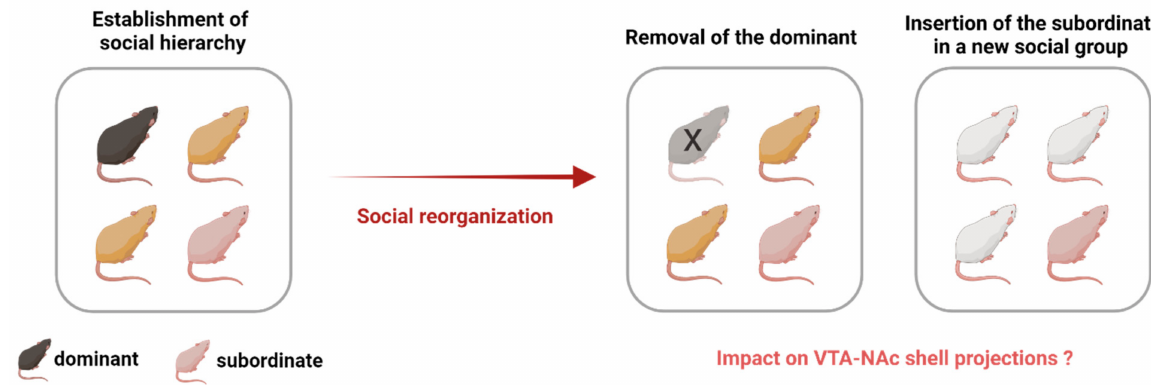
Figure 3. Social reorganization after the establishment of social hierarchy. Social ranks can be manipulated by removing the dominant so that a new dominance can be established, or social reorganization can occur by placing the subordinate into a new social group. What is the impact of social rank reorganization on the mesolimbic system, particularly on the VTA-NAc shell projections? In addition, what is the subsequent impact on the effects of drugs of abuse? Answering these questions will elucidate whether attaining dominance or moving to a new social group can result in adaptations in the VTA-NAc shell projections, possibly affecting the response to drugs of